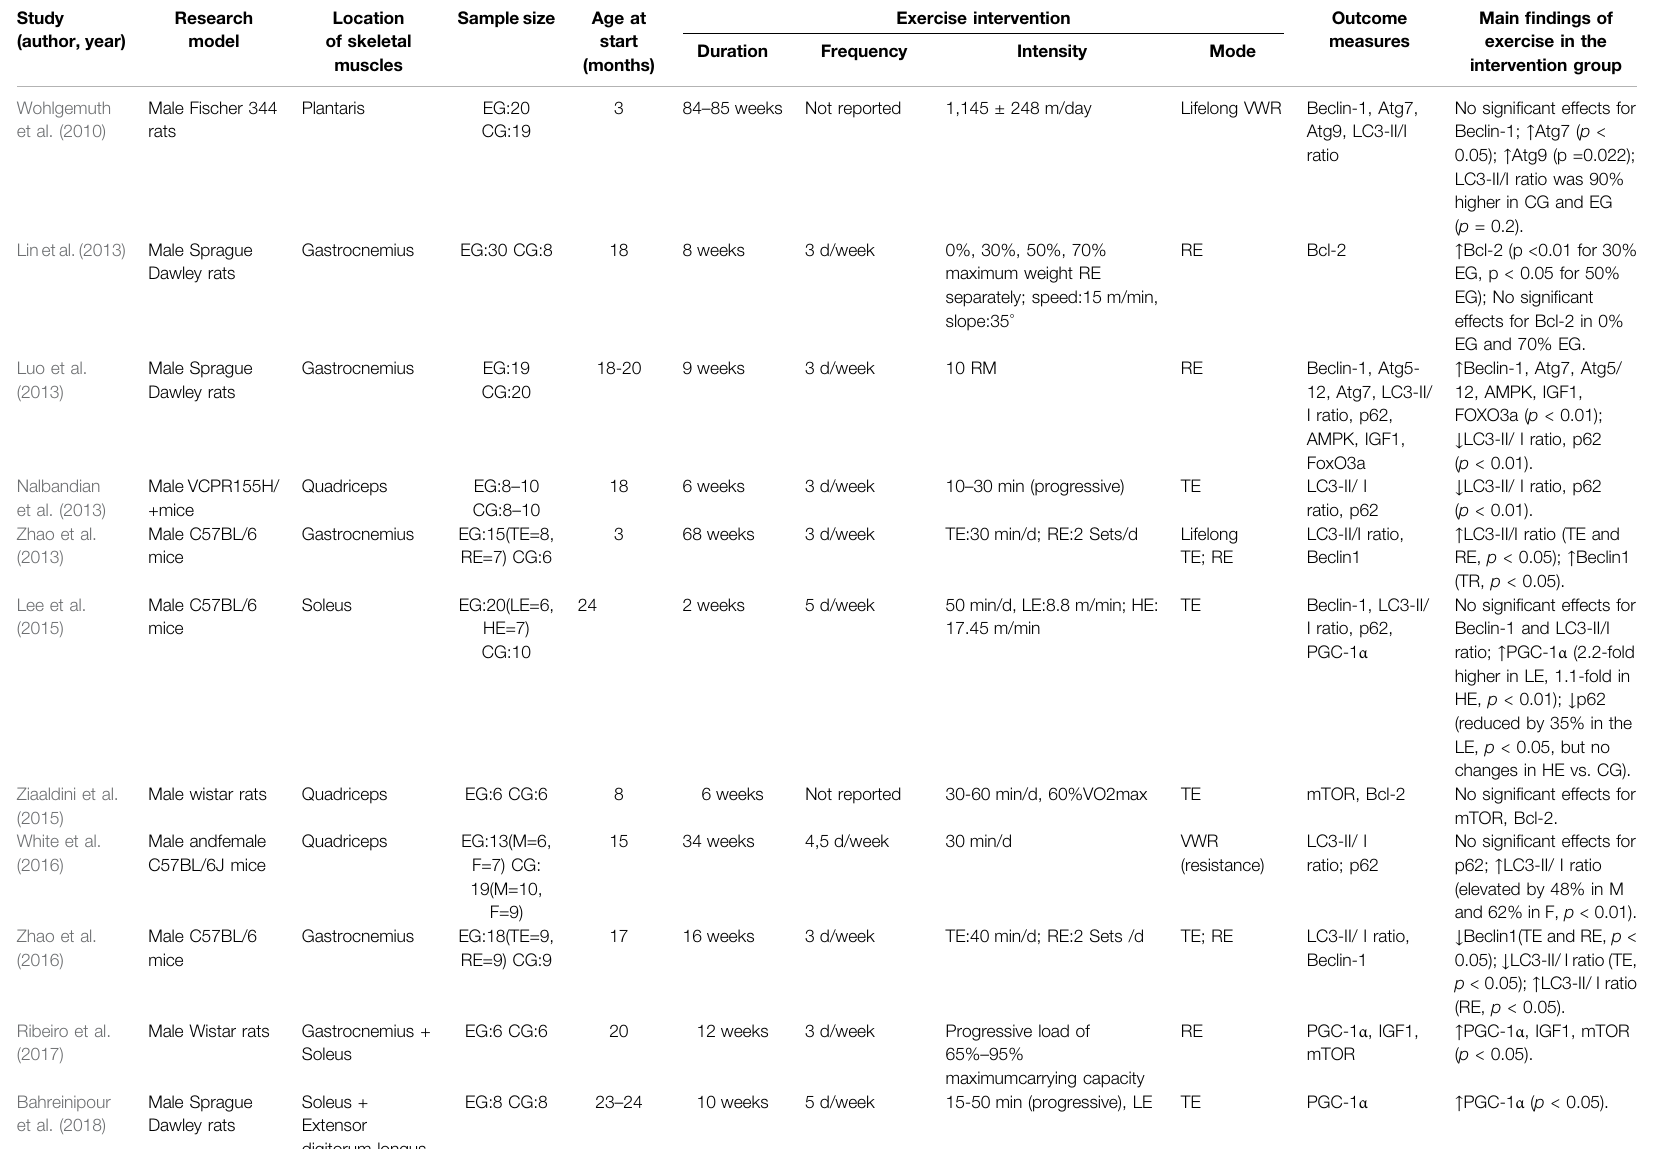
TABLE 2 | A summary of the reviewed